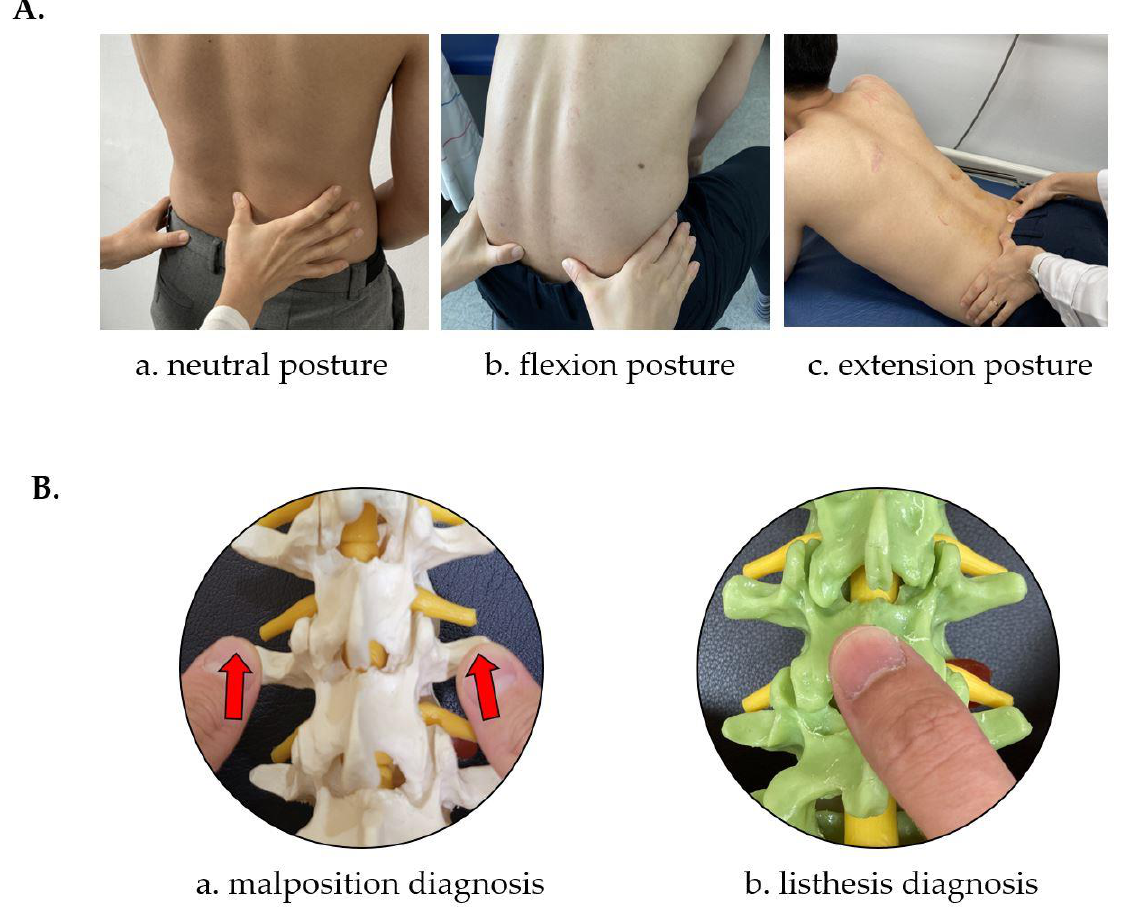
Figure 3. Practical example describing the actual diagnosis and palpation position. ( A ), posture for performing manual diagnosis in Chuna manual therapy; ( B ), contact point for diagnosis of malposition (( a ) transverse process) and listhesis (( b ) spinal process). Copyright 2022. Jin-Hyun Lee all right reserved.